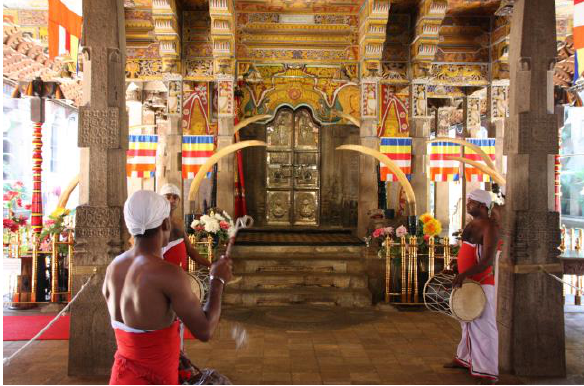
Fig. 2. Drum beating corridor and main side of the shrine 2. HERITAGE AT